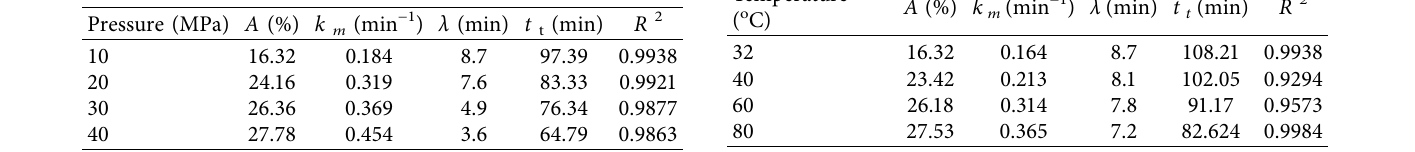
Figure 2: Effect of scCO 2 pressure (a) and temperature (b) on the extraction lipids from municipal sewage sludge. Exp: experimental data, Cal: calculated values by fitting the modified Gompertz equation to experimental data. Table 2: Estimated kinetics parameters of the modified Gompertz Table 1: Estimated the kinetics parameters of the modified equation for MSS lipids’ extraction at various scCO 2 Gompertz equation for the extraction of lipids from municipal sewage sludge (MSS), with varying scCO 2 pressures.